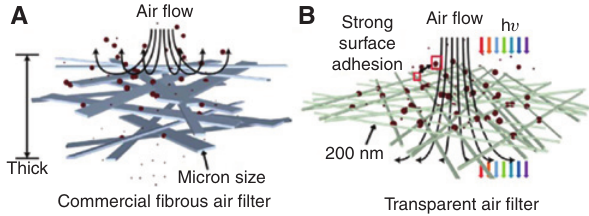
Figure 2: Schematics of (A) bulky fibrous air filter capturing PM particles by thick physical barrier and adhesion; (B) transparent air filters that capture PM particles by strong surface adhesion and allowing a high light and air penetration. For details, see Ref. [23]; reprinted with permission from Nature Publishing Group.